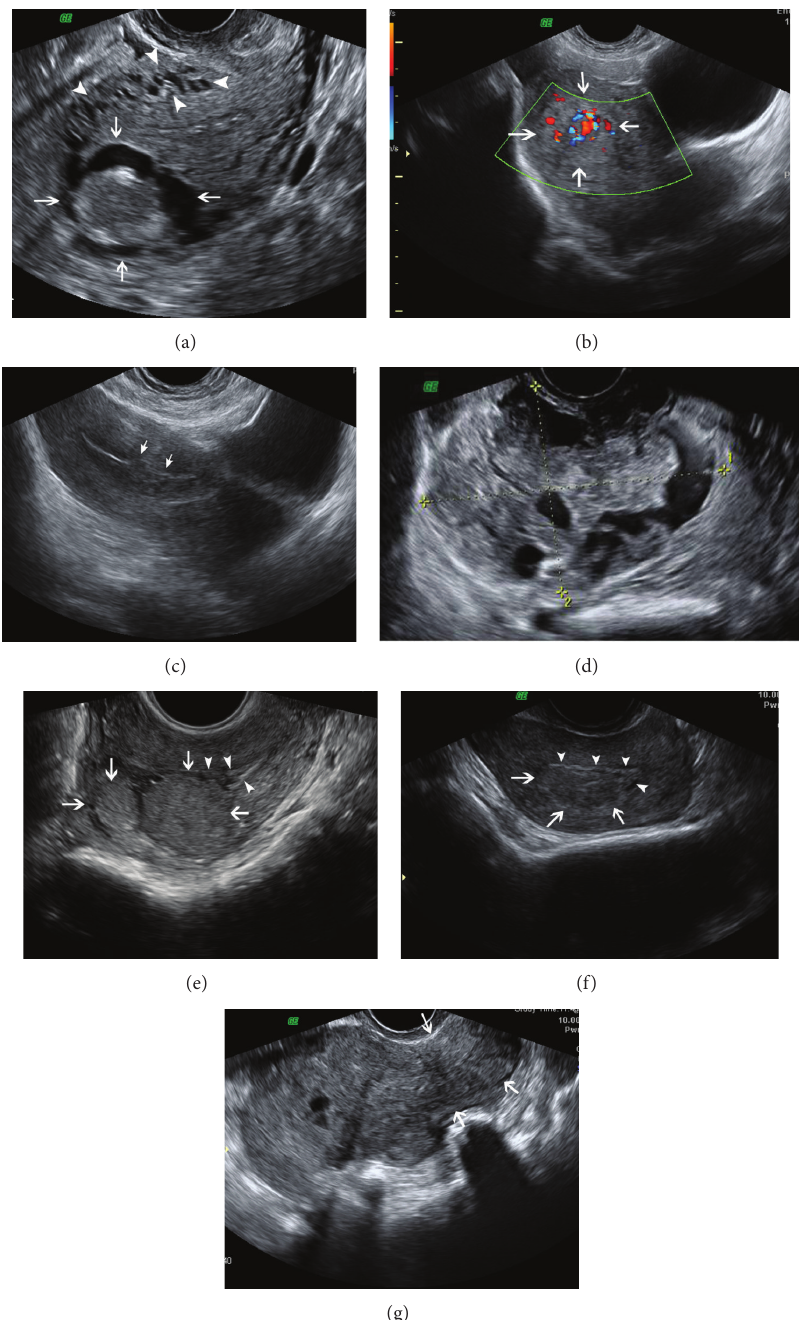
Figure 3: Sonographic spectrum of GTN. (a) Complex solid-cystic mass in the uterine fundus with myometrial epicenter (arrows) on sagittal TVS. Anechoic serpiginous structures in the adjoining myometrium represent increased vascularity (arrowheads). (b) Predominantly echogenic myometrial mass (arrows) effacing the zonal anatomy of uterus on Sagittal TAS. Color flow Doppler ultrasound reveals prominent vascularity in the lesion. (c) Small hypoechoic lesion (arrows) with irregular margins in the lower uterine body, disrupting the endometrial stripe and invading the adjoining myometrium on Sagittal TAS. (d) Ill-defined multicystic myometrial mass (between cursors) on transverse TVS. (e) Two round well-defined submucosal myometrial GTN lesions (arrows) with homogeneous isoechoic to hyperechoic echotexture, indentingtheendometrialstripe(arrowheads)andpartiallyeffacingitonsagittalTVS,resemblingsubmucosalfibroids.(f)Anovoidisoechoic mass with irregular margins (arrows) at endomyometrial interface on sagittal TVS simulating an adenomyoma or a submucosal fibroid. Arrowheads = endometrium (g) Enlarged uterus with a lobulated contour and heterogeneous echotexture on sagittal TVS. Arrows =